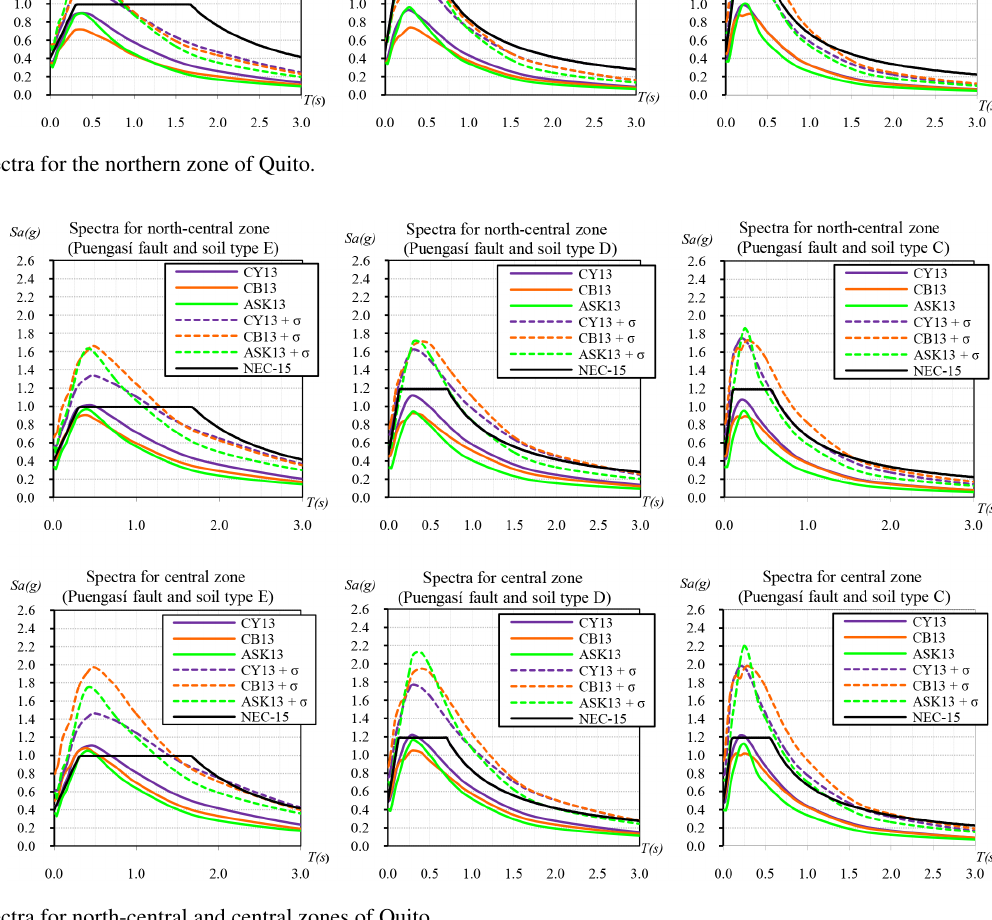
Figure 7. Spectra for north-central and central zones of